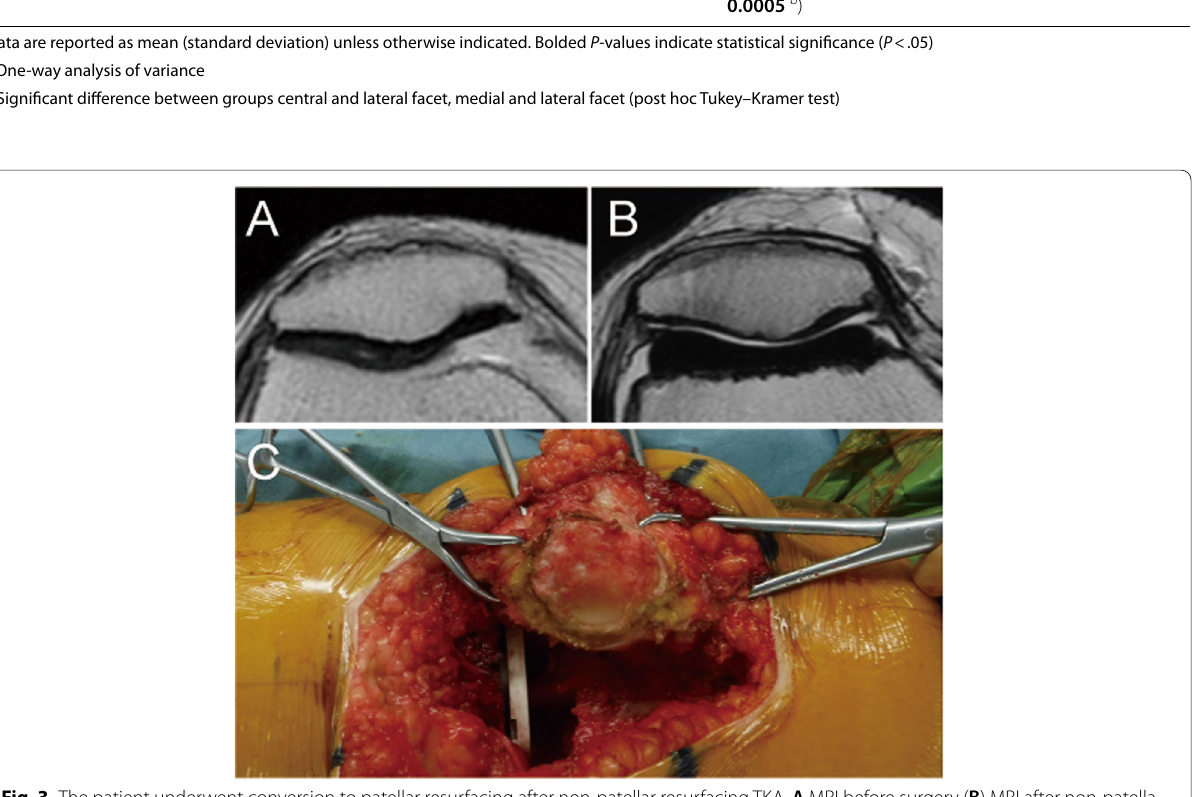
Fig. 3 The patient underwent conversion to patellar resurfacing after non-patellar resurfacing TKA. A MRI before surgery ( B ) MRI after non-patella resurfacing TKA; the patella thickness is decreased compared to the thickness before TKA ( C ) Intraoperative view of the patellar cartilage reveals excessive articular cartilage wear of the patella in patients undergoing non-patella resurfacing total knee arthroplasty. TKA, total knee arthroplasty; MRI, magnetic resonance